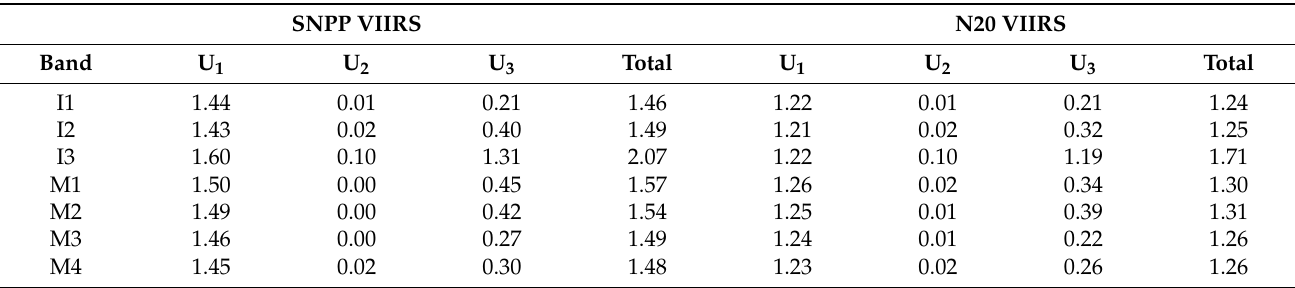
Table 7. SNPP and N20 VIIRS lunar calibration uncertainty. The uncertainties are listed as a percent-